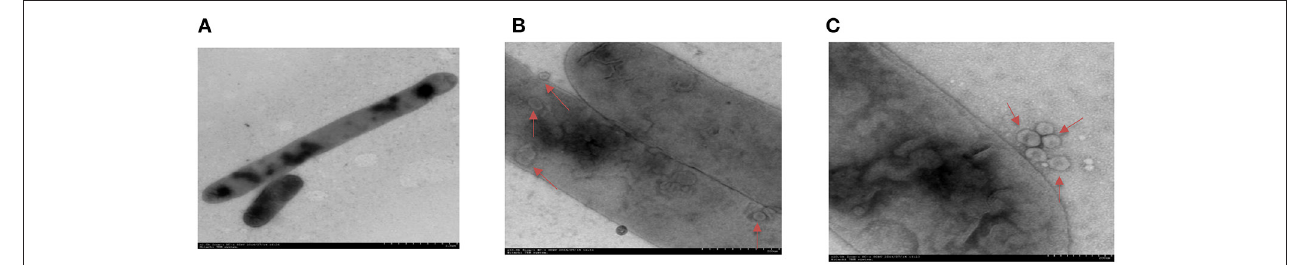
FIGURE 1 | Transmission electron micrographs image of H. parasuis and nascent OMVs. (A) Image of H. parasuis H45 strain which stained with uranyl acetate. (B) Transmission electron micrographs image of OMVs (red arrow) located at intracellular of H. parasuis H45 strain. (C) Transmission electron micrographs image of OMVs (red arrow) located at extracellular of H. parasuis H45 strain.